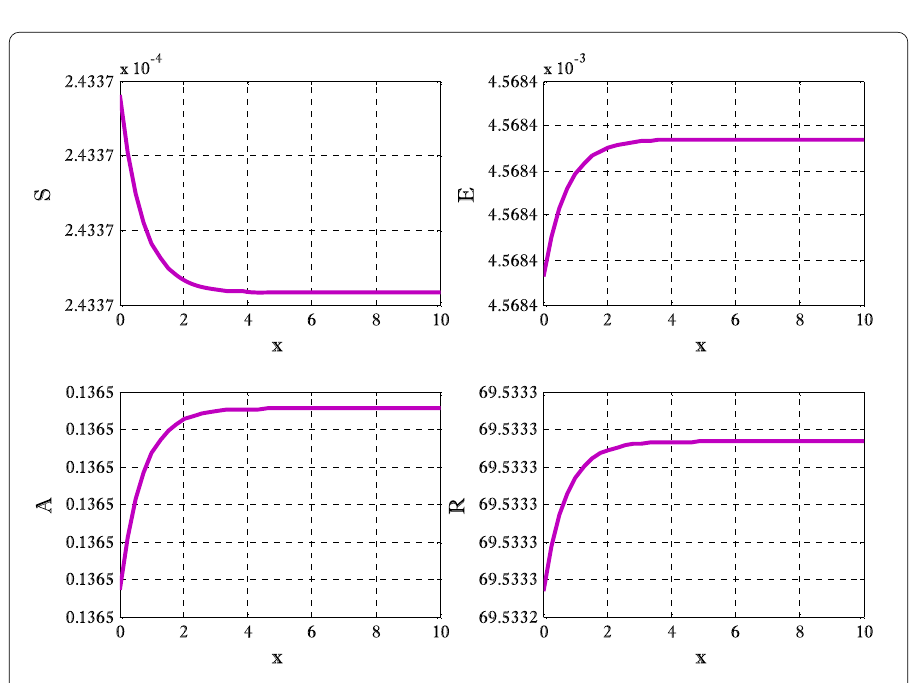
Figure 12 Solution obtained by Euler method using t = 10, N x = 40, N t = 190, α = 0.1, β = 0.3, γ = 0.4, σ = 0.1, μ = 0.4, d 1 = d 2 = d 3 = d 3 = d 5 = 0.9